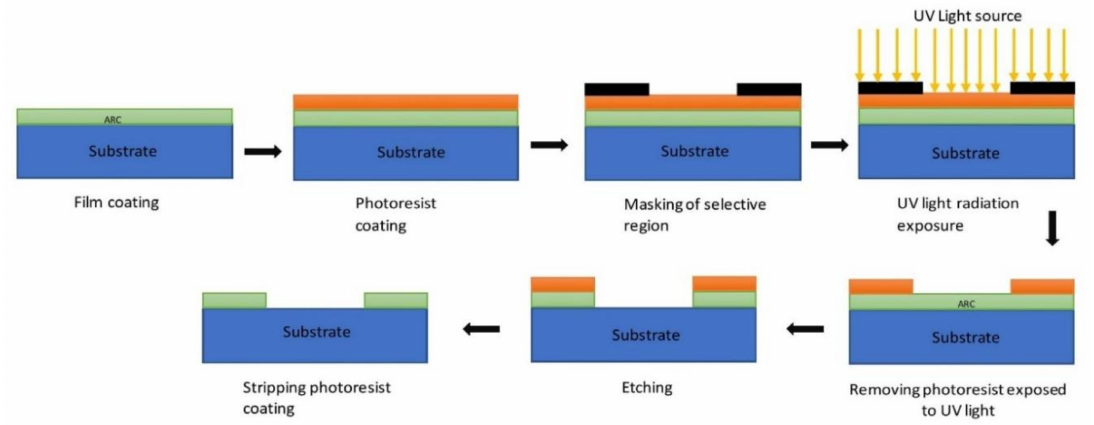
Figure 12. Schematic illustration of steps involved in